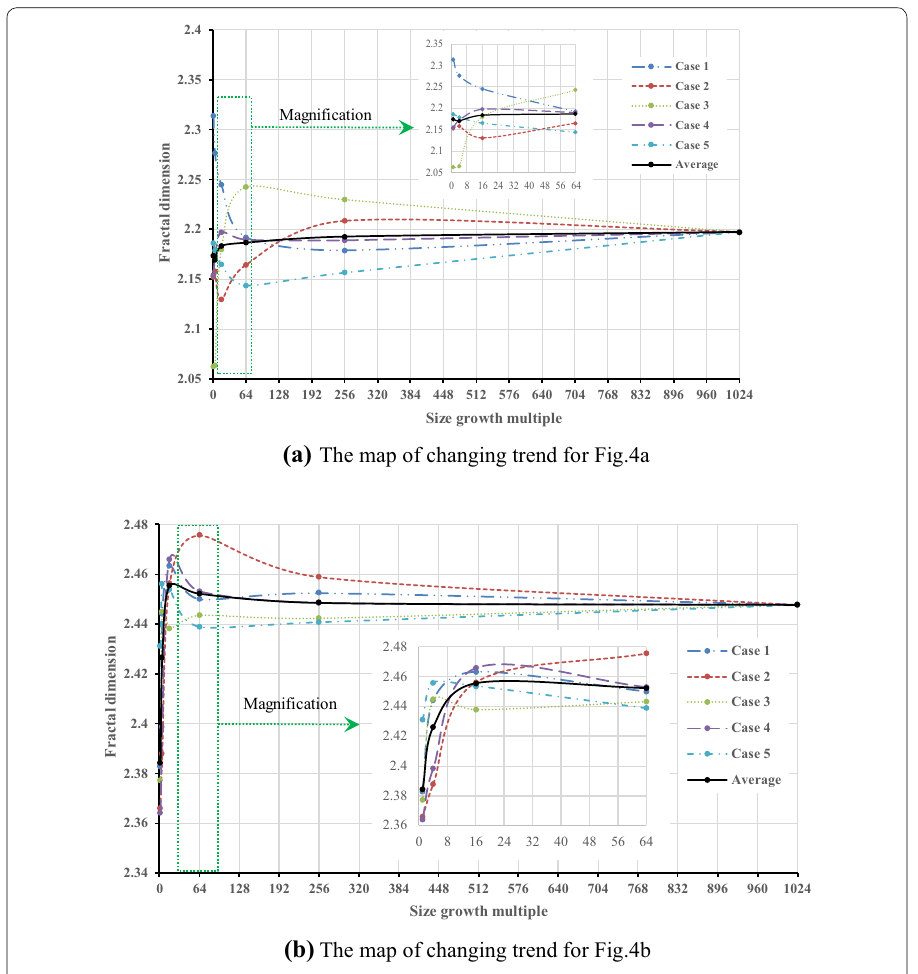
Fig. 8 The relationship between the fractal dimension and the size growth multiple at five